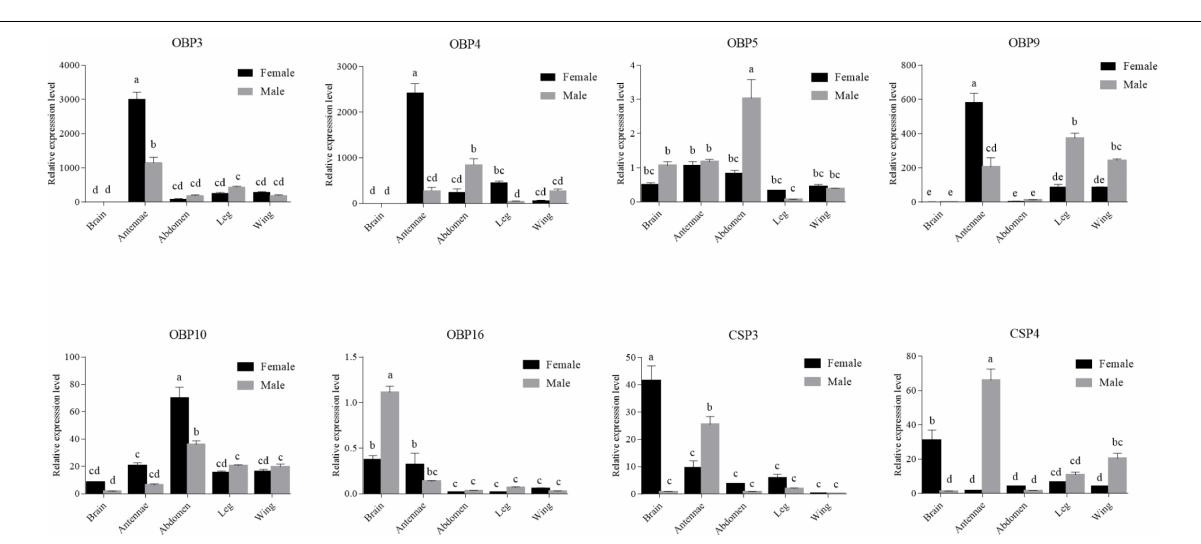
FIGURE 8 | Six OBPs and two CSPs transcript levels in different tissues of both sexes as evaluated by RT-qPCR. The internal controls β -actin and gapdh were used to normalize transcript levels in each sample. The standard error is represented by the error bar, and the different letters above each bar denote significant differences ( p <